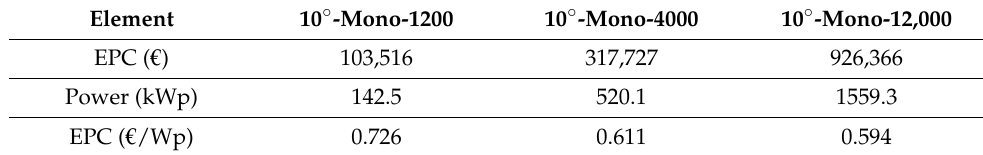
Table 3. EPC costs, both absolute and normalized, for the three base